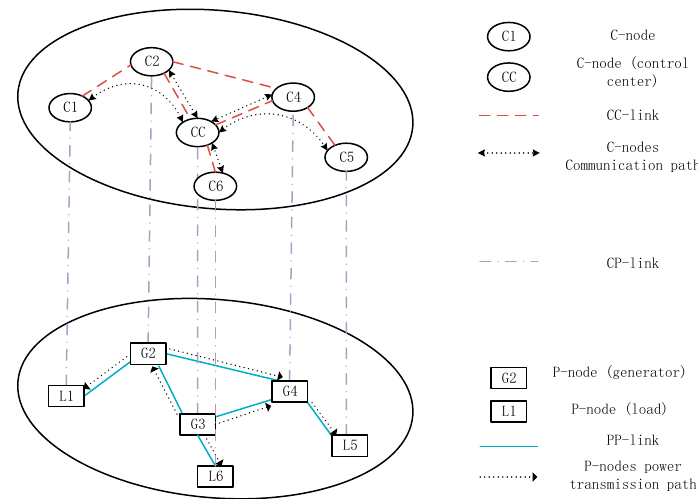
Figure 2. Node–link relationships in a Figure 2. Node – link relationships in a CPPS.